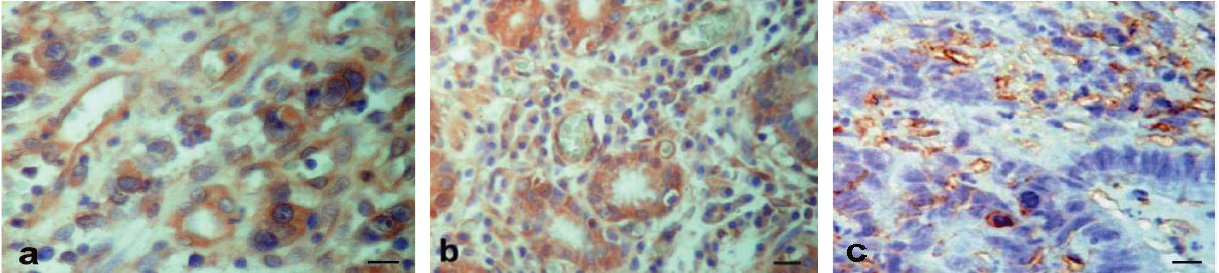
Figure 2. Representative sections of GITC immunohistochemically stained with VEGF in tumor cells and blood vessels in the center of the tumor ( a ), periphery ( b ) and metastasis ( c ) regions. Note the nuclear staining in tumor cells and the presence of blood vessels in the proximity of tumor glands in the periphery region. In (a) and (c), bar = 25 (cid:3) m